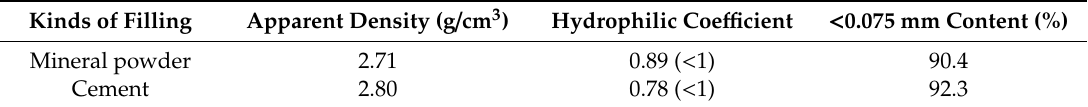
Table 4. Properties of the mineral powder and the cement.